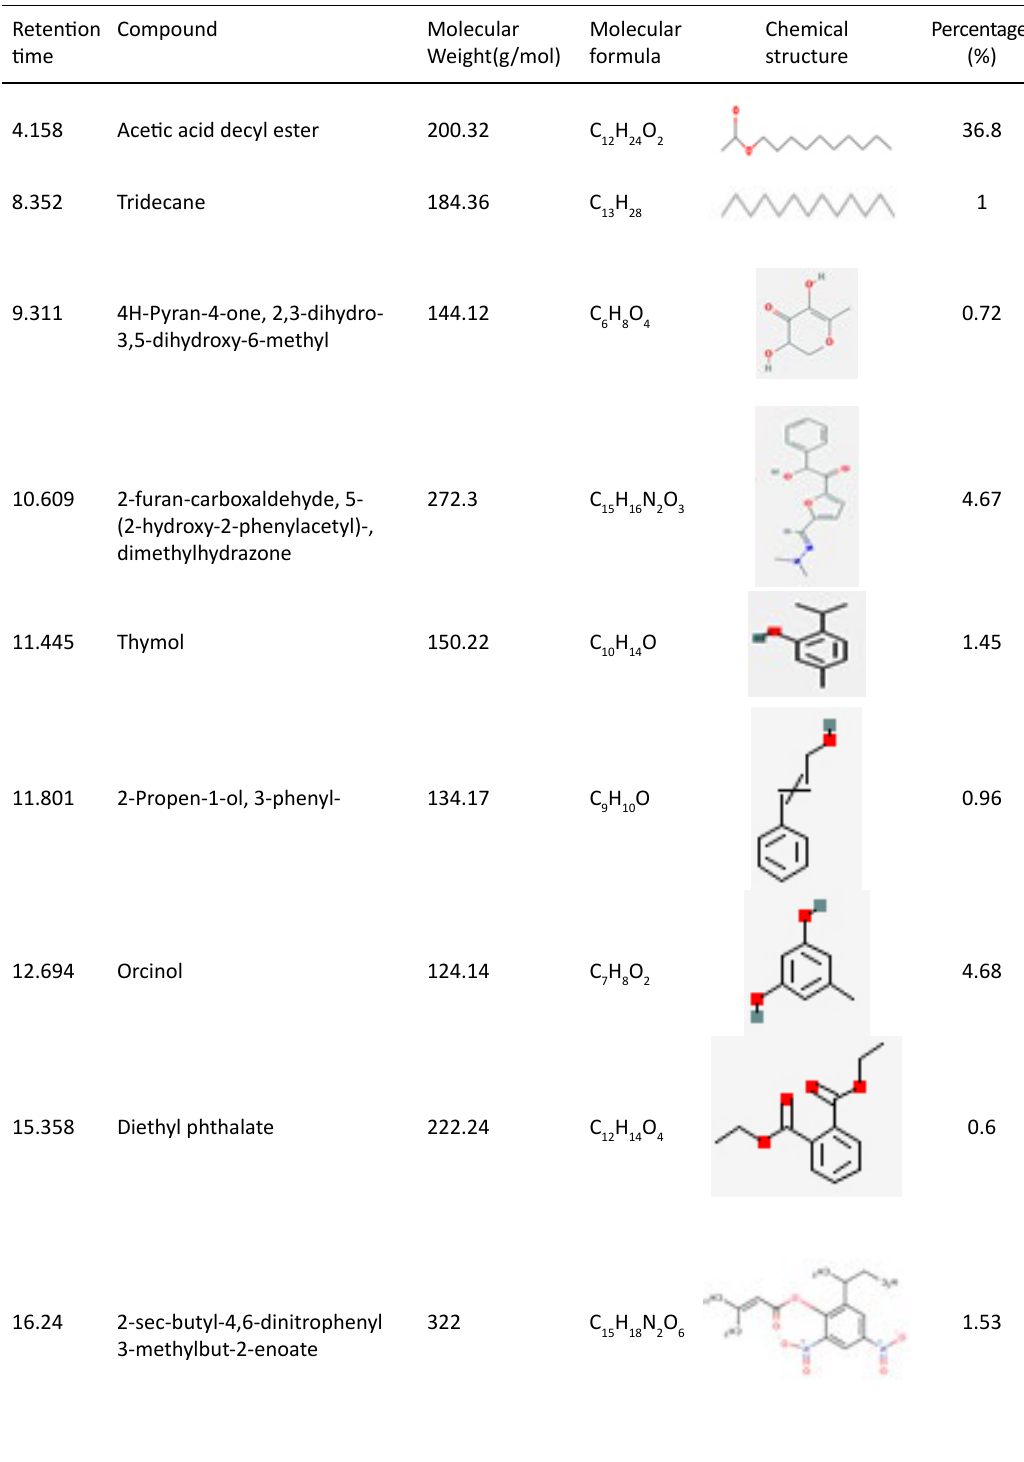
Table 1. GC-MS analysis report for the methanol extract of Hyphaene thebaica (Doum) fruits Retention Compound Molecular Molecular Chemical Percentage time